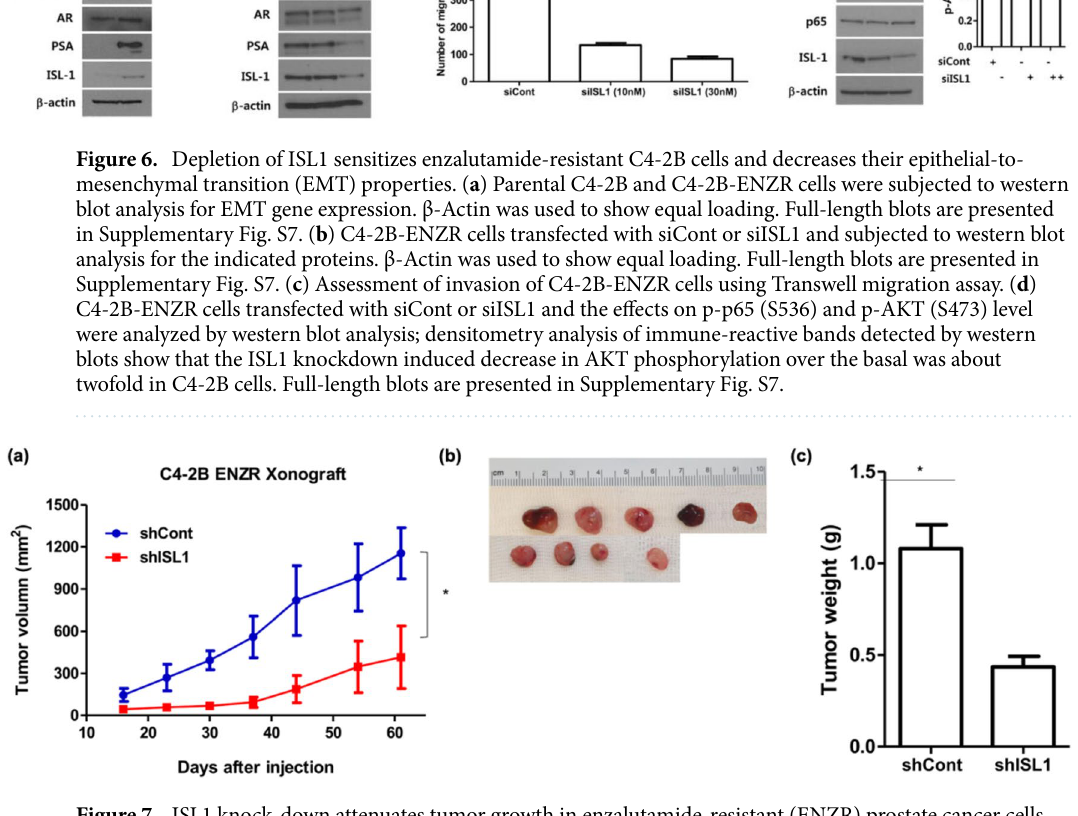
Figure 7. ISL1 knock-down attenuates tumor growth in enzalutamide-resistant (ENZR) prostate cancer cells. ( a ) The efficiency of ISL1 knock-down was measured by western blot analysis. b-action was used to show equal loading. ( b ) Photographs showing tumor formation in nude mice injected with stable cell lines with ISL1 knockdown. Tumor growth curves in relation to the ISL1 suppression in human CRPC C4-2B ENZR xenografts. Tumor size was measured once per week and compared between groups by ANOVA (* p < 0.001). ( c ) Relationship between tumor weights and ISL1 expression status in human CRPC xenograft model. Tumors were excised and examined at the end of the experiments. Representative graph is shown as vertical box plots and tumor weights are presented as mean (g)